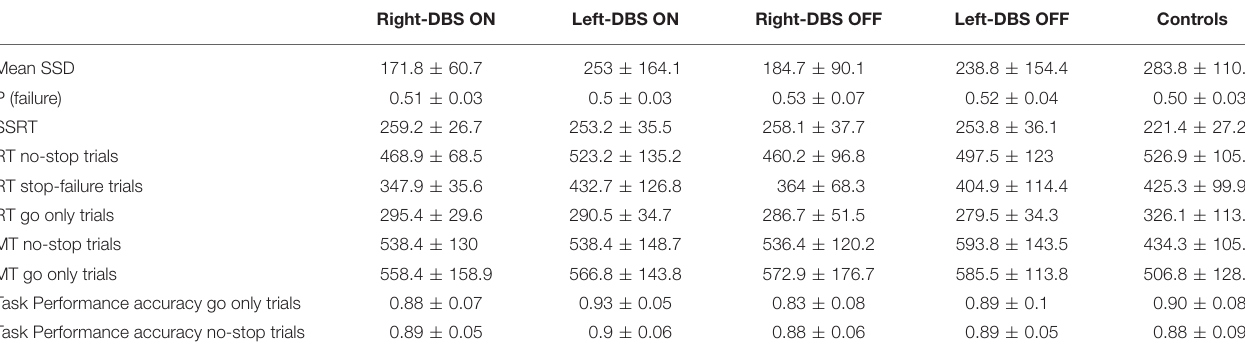
TABLE 3 | Summary of behavioral values of arm movements for Parkinson’s disease patients with deep brain stimulator (DBS) implanted on the right side (right-DBS), on the left side (left-DBS) in ON and OFF states, and for age-matched controls during the countermanding and the go-only tasks. Right-DBS ON Left-DBS ON Right-DBS OFF Left-DBS OFF Controls